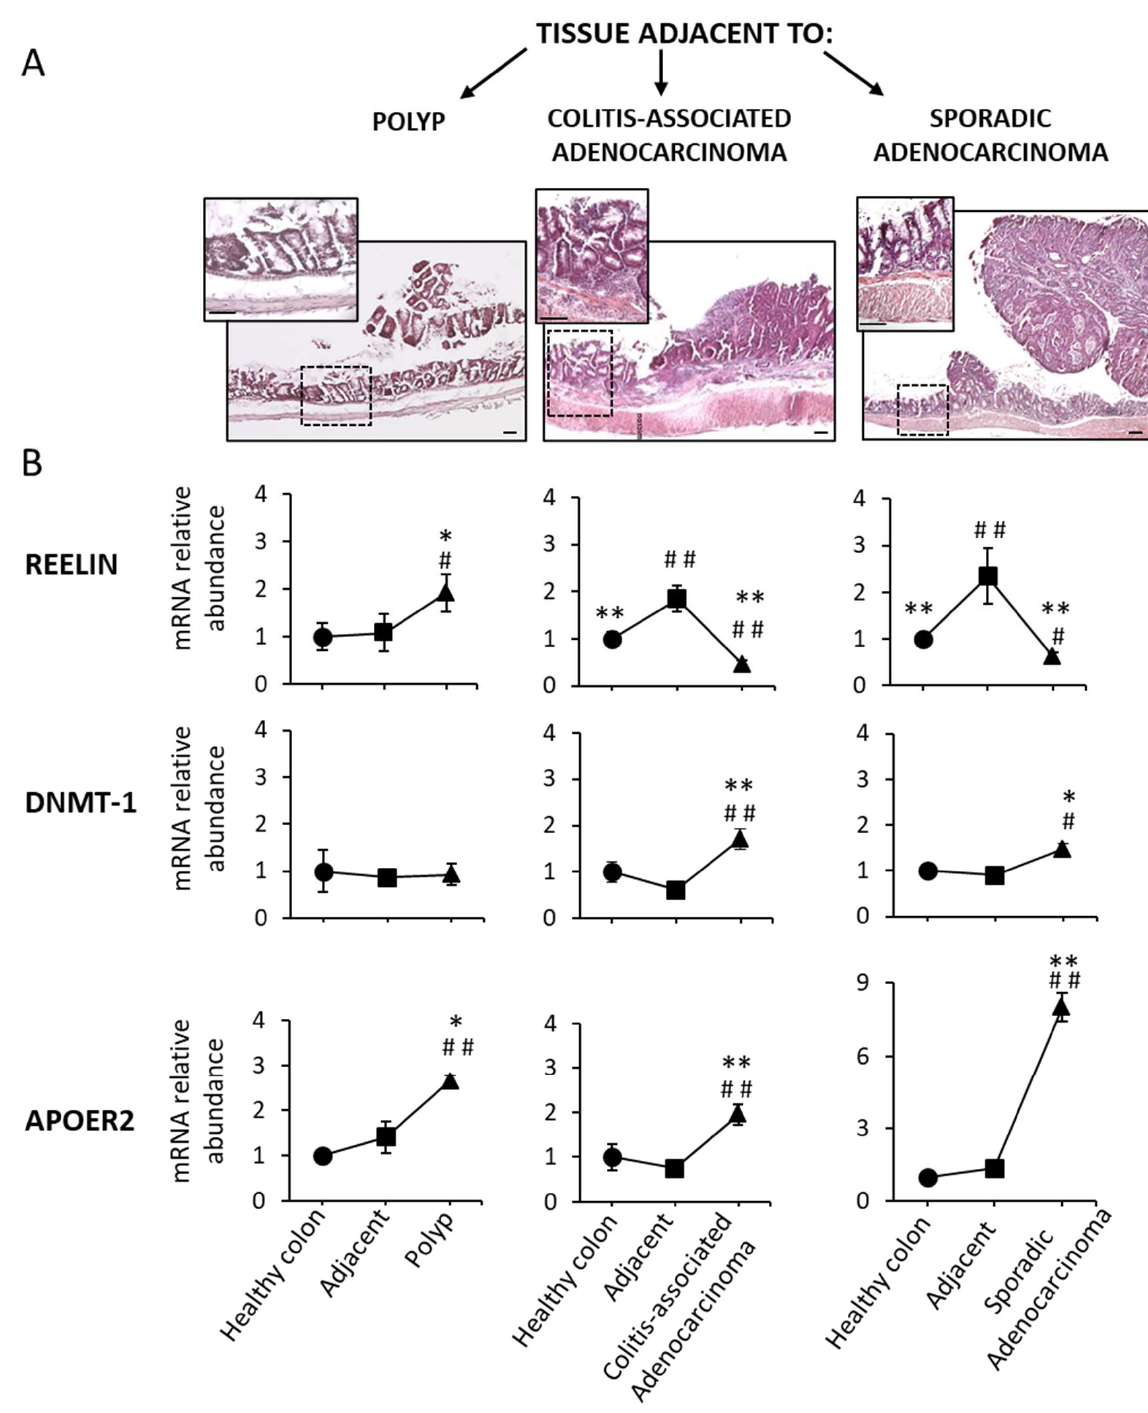
Figure 5. Reelin, DNMT-1 and ApoER2 mRNA relative abundance in the tissue adjacent to polyps and adenocarcinomas in mouse colons. ( A ) Representative photographs of each lesion and its adjacent tissue (inserts). In total, 5 µ m embedded paraffin sections were stained with an eosin–hematoxylin procedure. Scale bars represent 200 µ m. ( B ) Graphs represent mRNA abundance of reelin, DNMT-1 and ApoER2 in the healthy colon (control), in the tissue adjacent to each lesion and in the lesion itself (either polyp, colitis-associated adenocarcinoma or sporadic adenocarcinoma). The mRNA abundance value obtained for each gene was calculated considering that of the healthy colon value 1. Data are means ± SEM ( n = 10 animals per group). ANOVA shows significant differences ( p < 0.01) in reelin, DNMT-1 and ApoER2 mRNA abundance between adjacent tissues and the lesions. Tukey’s test: # p < 0.05, ## p < 0.001 vs. healthy colon; * p < 0.05, ** p < 0.001 vs. adjacent tissue.